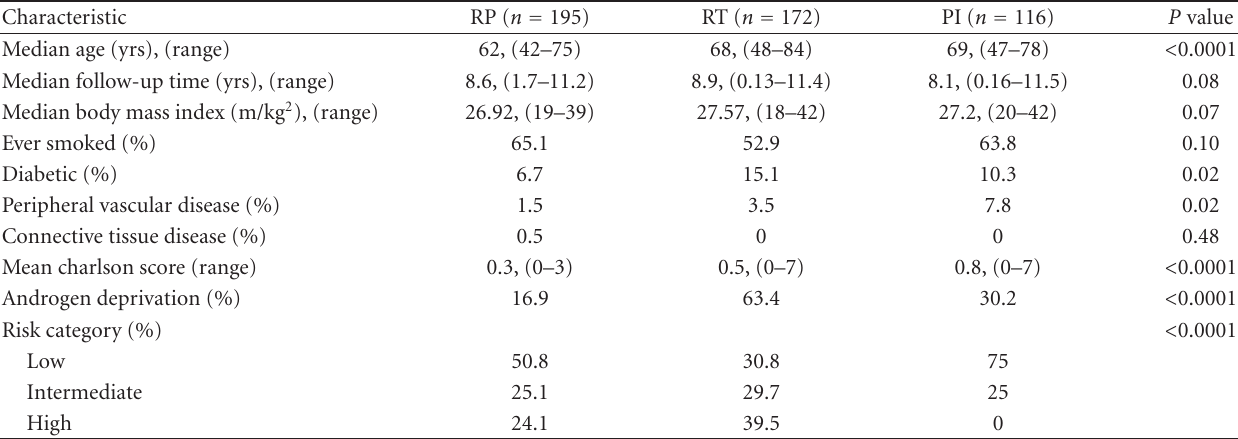
Table 1: Patient